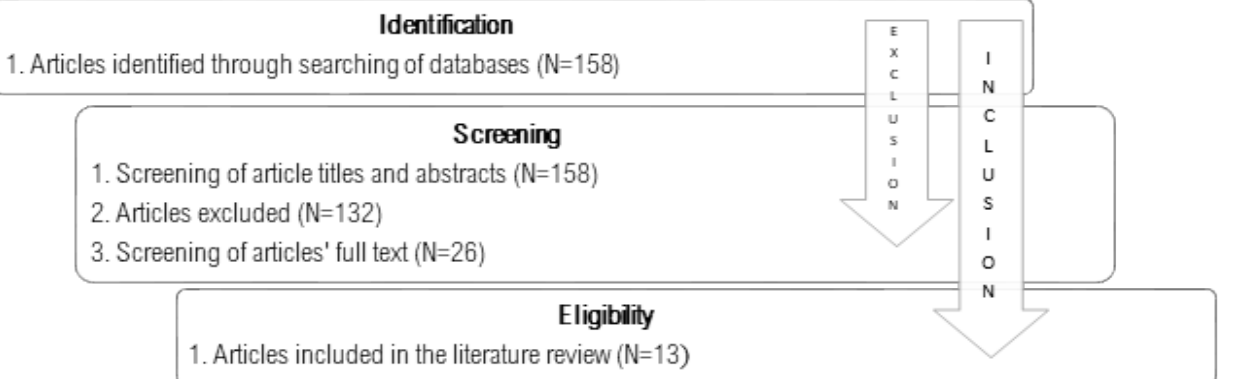
Method used for Article Identification and Data Extraction